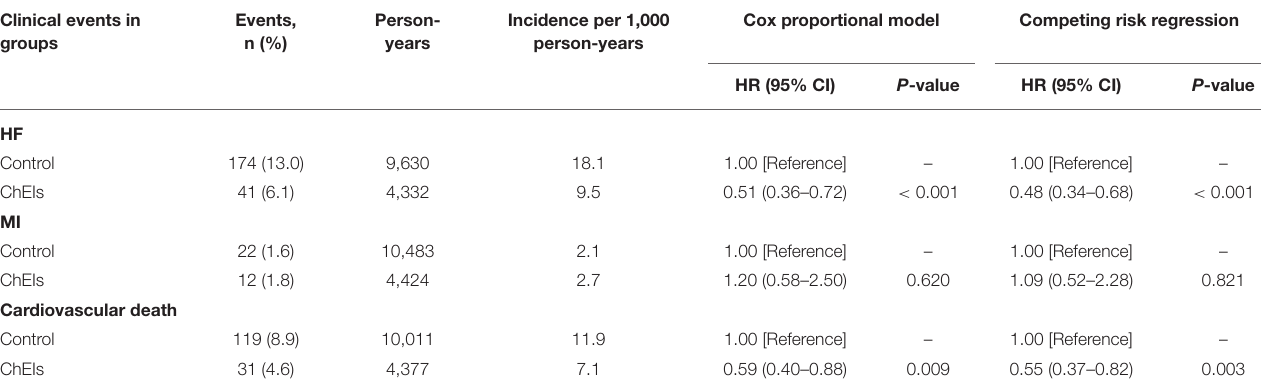
TABLE 2 | Clinical outcomes and relative risks between ChEI users and controls after 10-year follow-up. Clinical events in groups